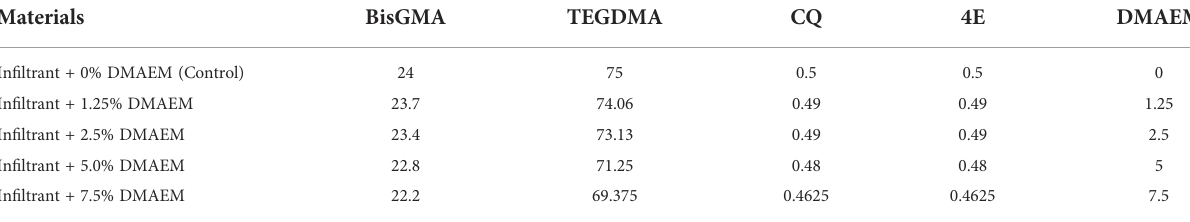
TABLE 1 Component of experimental resin in fi ltrant